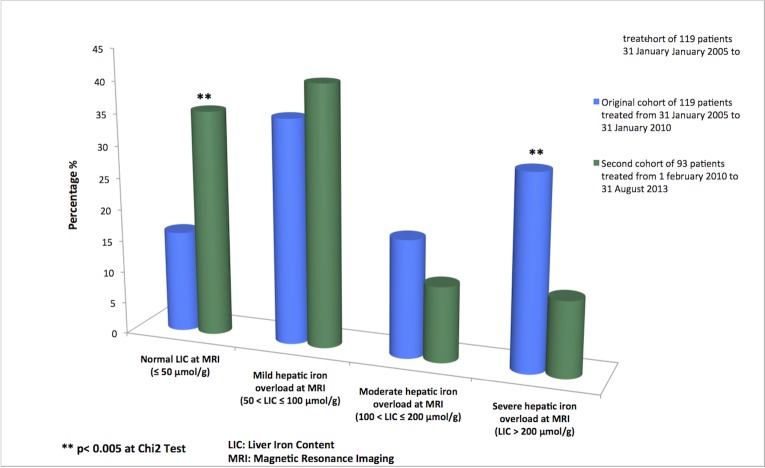
Histogram of liver iron content measured by quantitative MRI in two cohorts of hemodialysis patients treated with different ferritin and transferrin saturation targets for iron repletion.